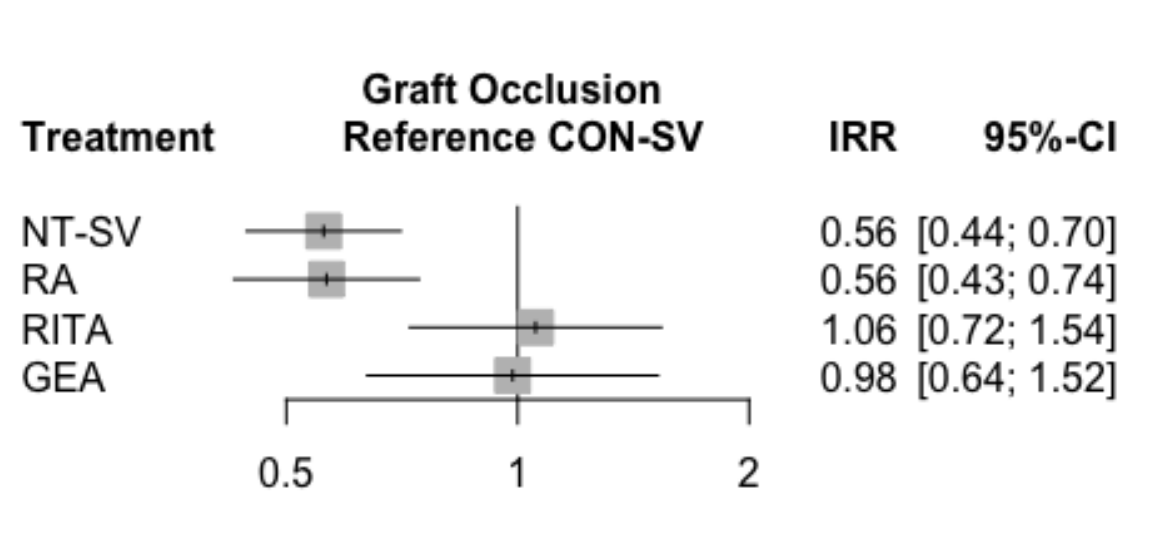
Fig. 1 - Forest plot for graft occlusion for the different conduits. CI=confidence interval; CON-SV=conventionally harvested saphenous vein; GEA=gastroepiploic artery; IRR=incidence rate ratio; NT-SV=no-touch saphenous vein; RA=radial artery; RITA=right internal thoracic